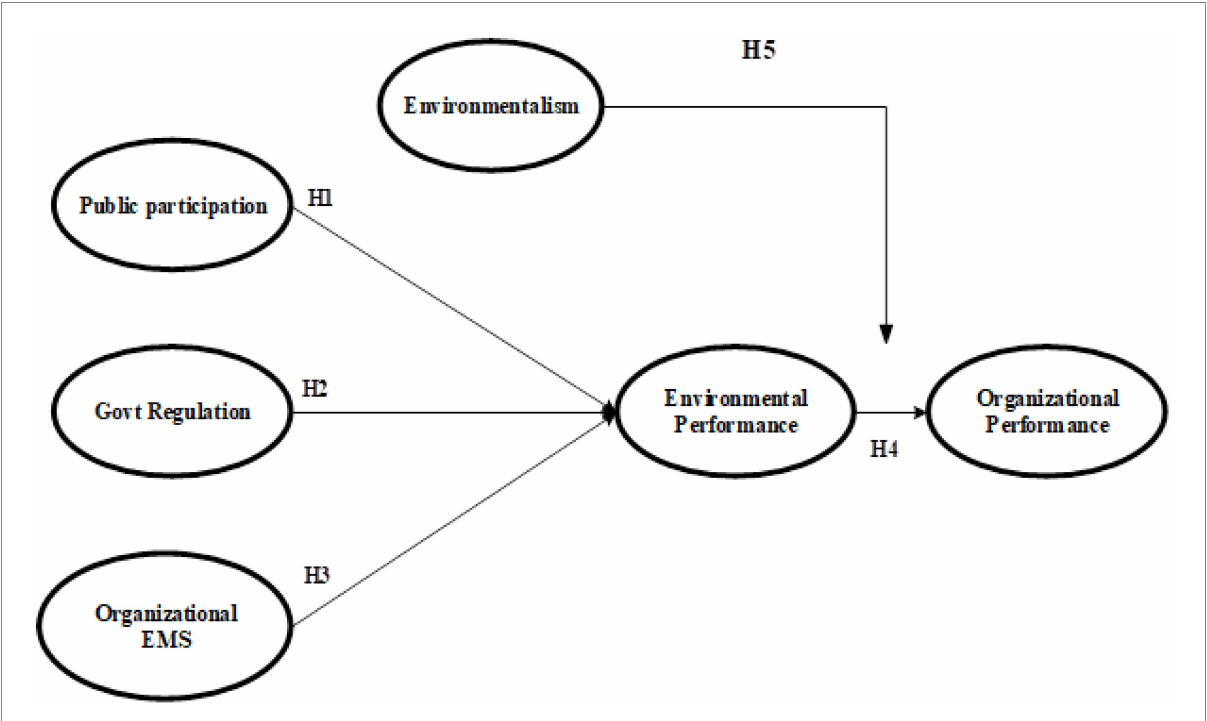
FIGURE 1 Theoretical